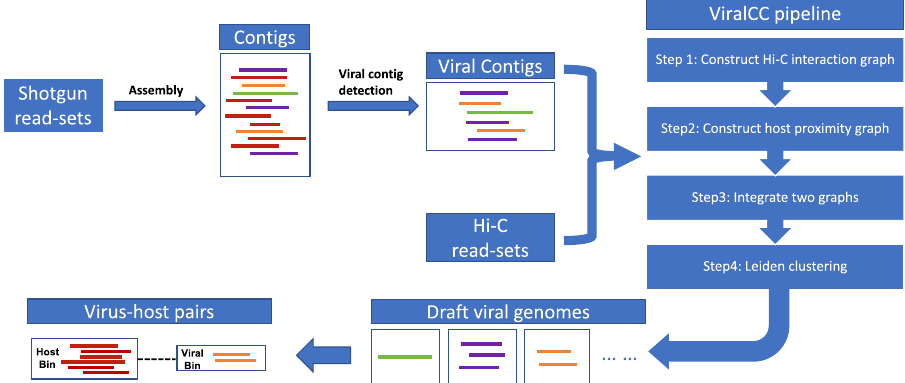
Fig. 1 | Overview of the ViralCC pipeline. The general work fl ow of ViralCC to retrieve high-quality viral genomes and determine virus-host pairs. Shotgun reads are fi rst assembled into contigs, to which Hi-C paired-end reads are aligned. Viral contigs are subsequently identi fi ed. Leveraging Hi-C linkages and the virus-host